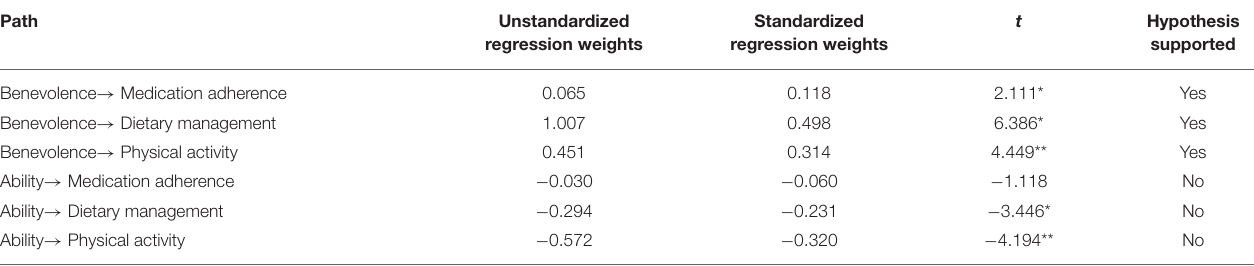
TABLE 6 | Results of structural equation modeling.